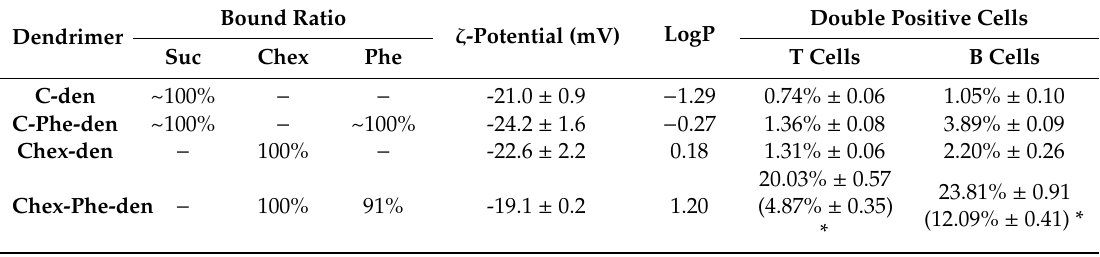
Table 1. Characterization and association with immune cells of di ff erent carboxyl-terminal dendrimers. Bound Ratio ζ -Potential Dendrimer